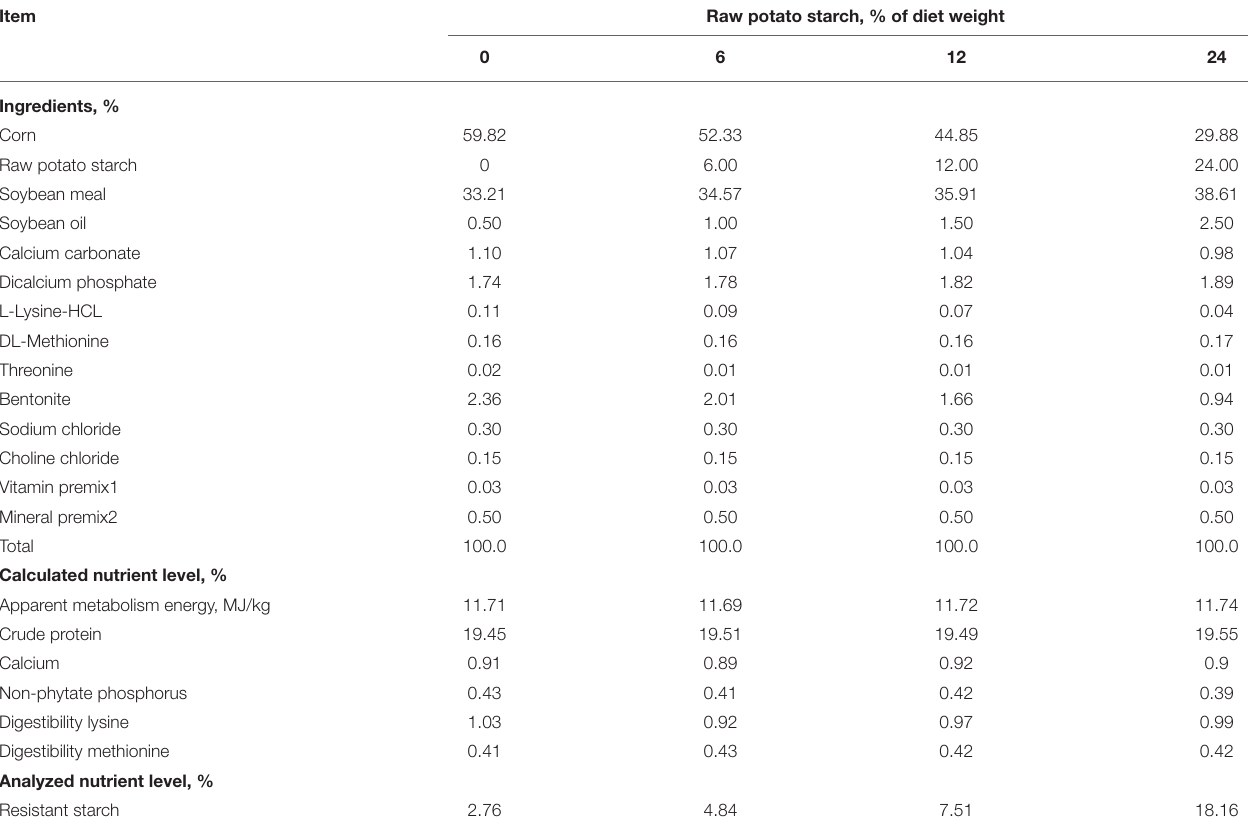
TABLE 1 | Dietary formulation and composition (as fed